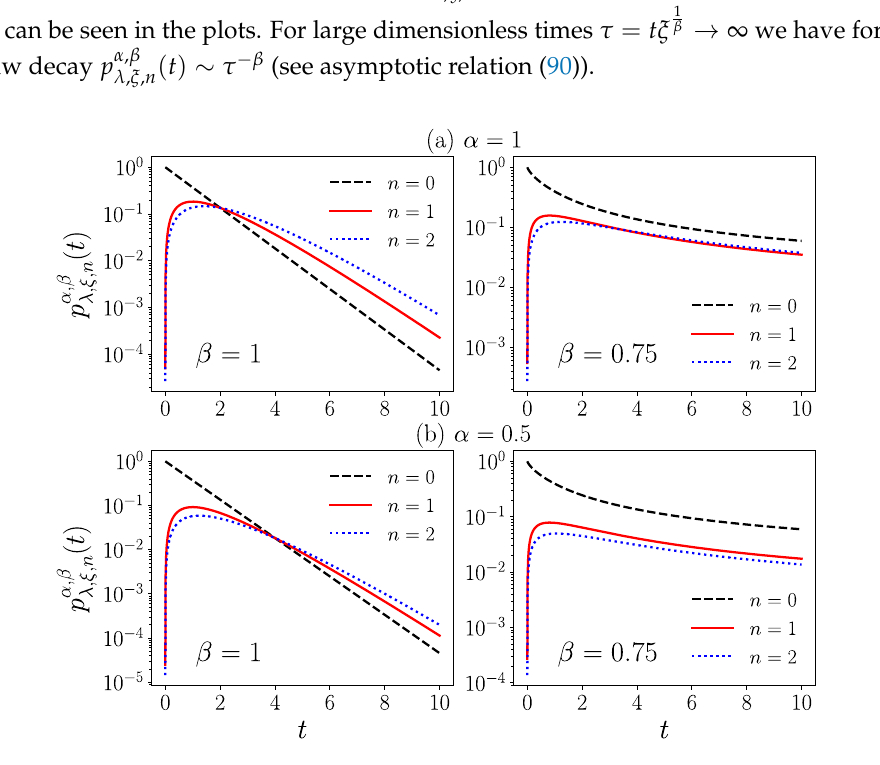
( t ) of the space-time Mittag-Leffler process as a function of t for: Figure 1. State-probabilities p α , β λ , ξ , n ( a ) α = 1.0 and ( b ) α = 0.5. The results are obtained numerically using Equation (83) for the values n = 0,1,2 and β = 1 (in the left panels) and β = 0.75 (presented in the right panels); we maintain constant the parameters λ = 1, ξ =